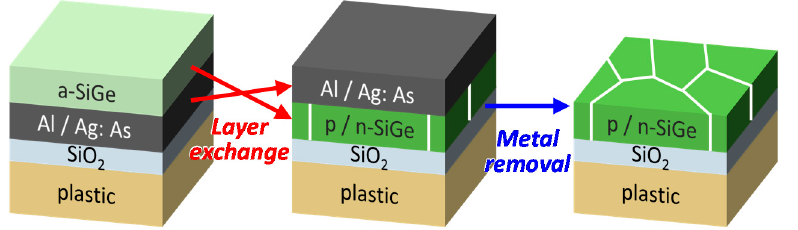
Figure 1. Schematic diagram of the LE process. The metal layer is Al for p-type Si 0.4 Ge 0.6 and Ag:As for n-type Si 0.85 Ge 0.15 .